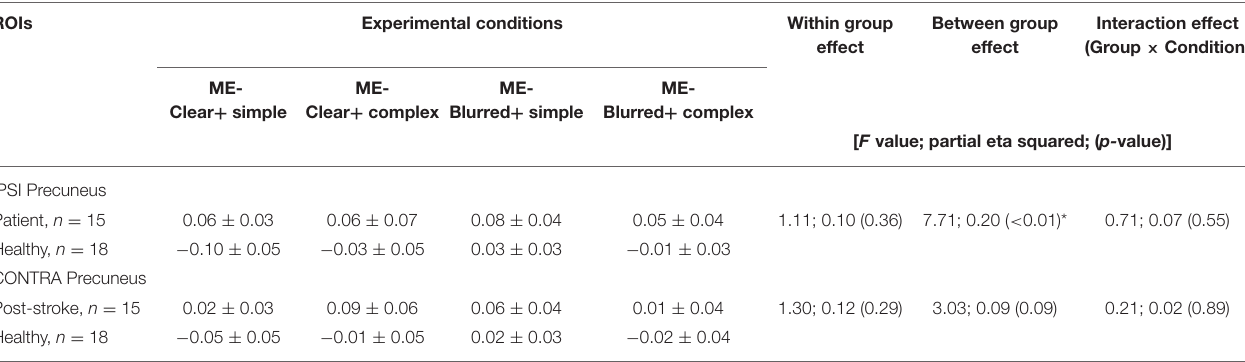
TABLE 4 | Changes in [HbO] (ME) in left and right Precuneus throughout 20s finger tapping among four conditions for patient ( n = 15) and healthy groups ( n = 18). ROIs Experimental conditions Within group Between group Interaction effect effect effect (Group × Condition) ME- ME- ME- ME- Clear + simple Clear + complex Blurred + simple Blurred + complex [ F value; partial eta squared; ( p-